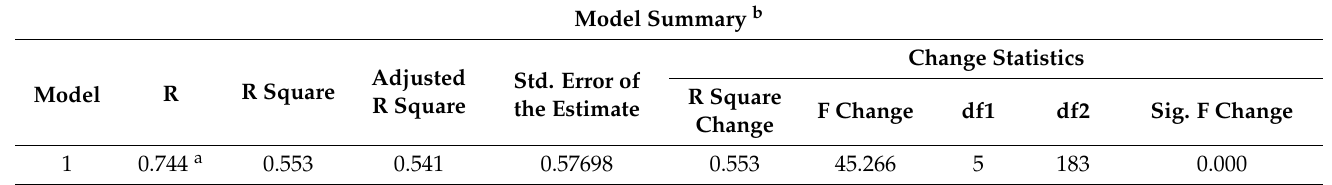
Table 12. Regression